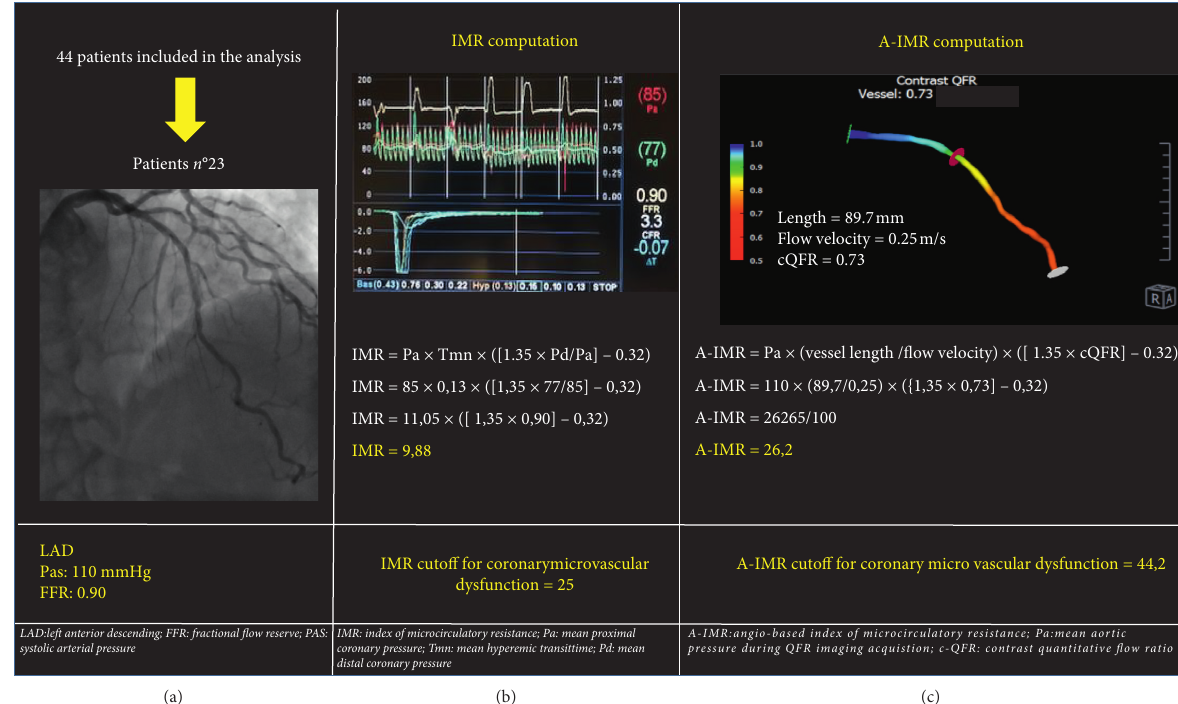
Figure 1: Example: (a) baseline characteristics; (b) IMR computation; (c) A-IMR computation.